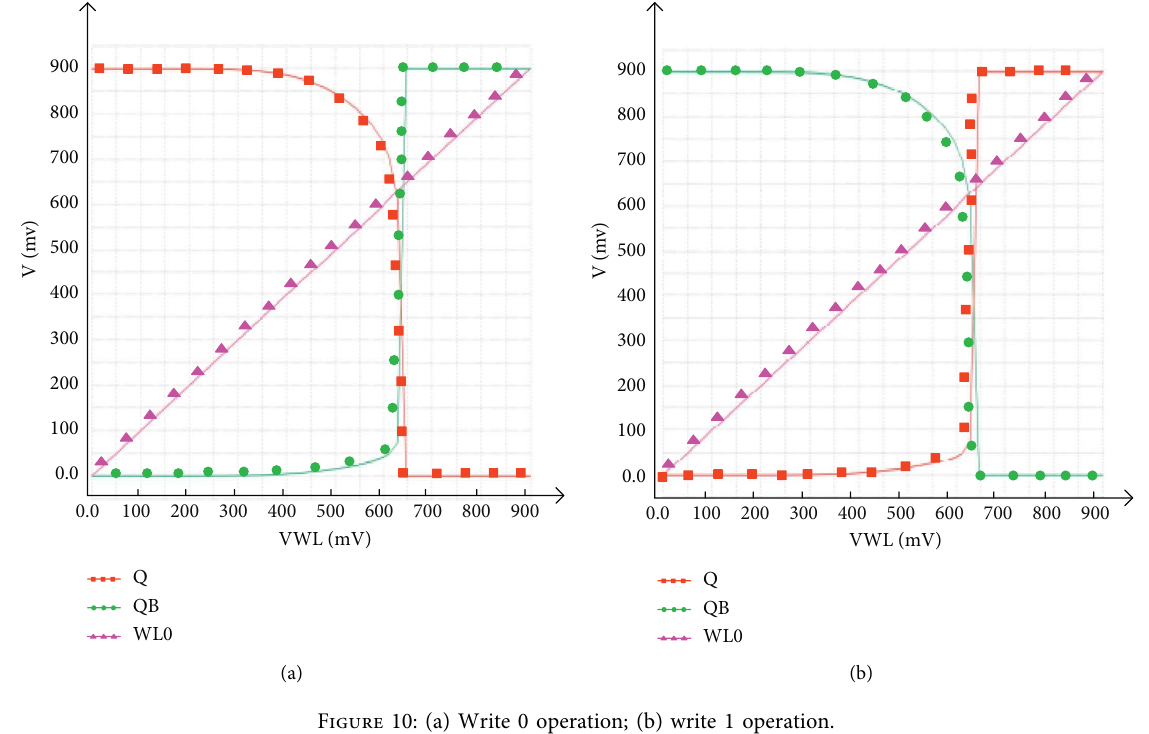
Figure 10: (a) Write 0 operation; (b) write 1 operation.